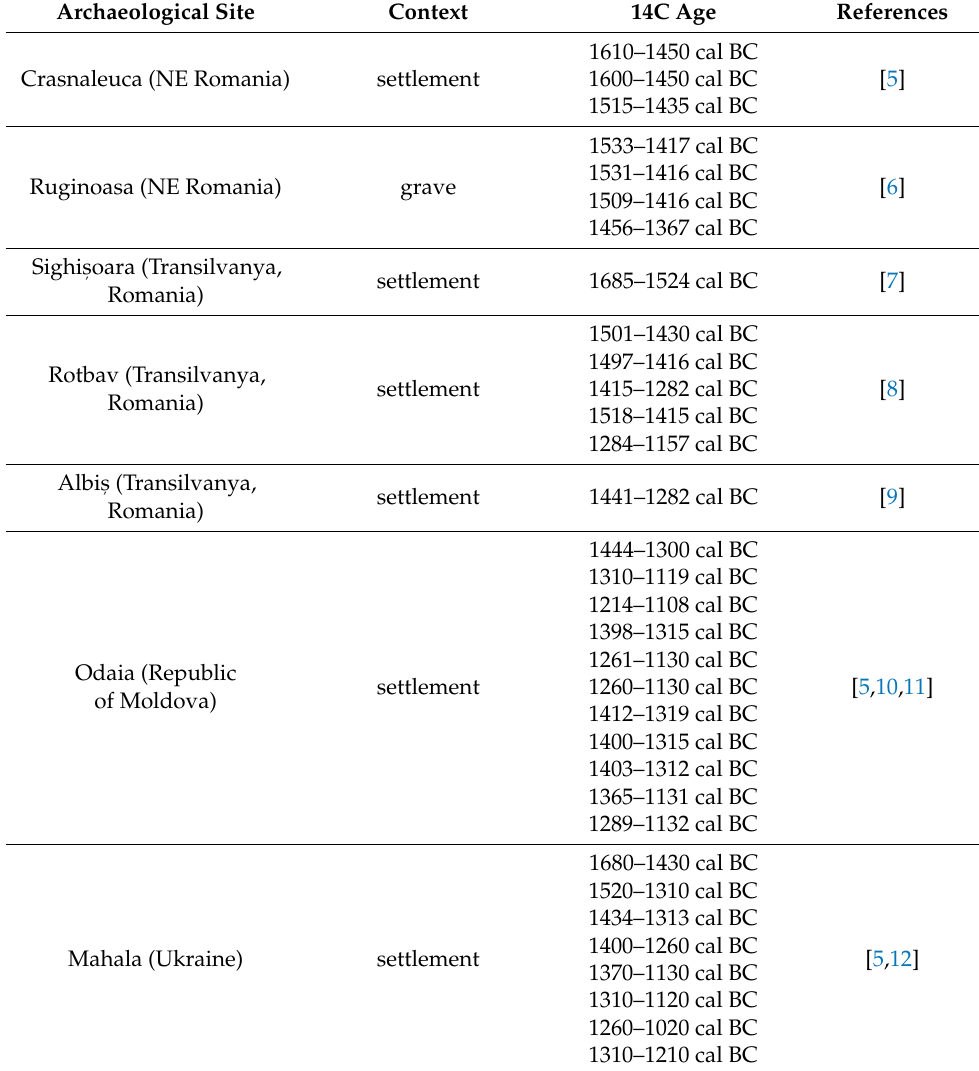
Table 1. Radiocarbon data obtained from various Noua culture